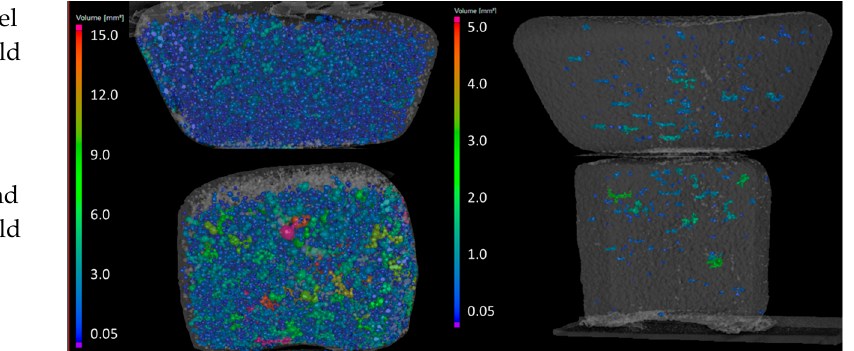
Figure 6. CT Scan of RPT specimens Level of Cleaning by Degassing Method.